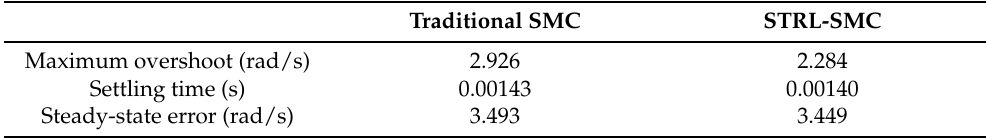
Figure 4. Rotor speed comparison between traditional SMC and STRL-SMC for speed tracking. Table 2. Performance index comparison between traditional SMC and